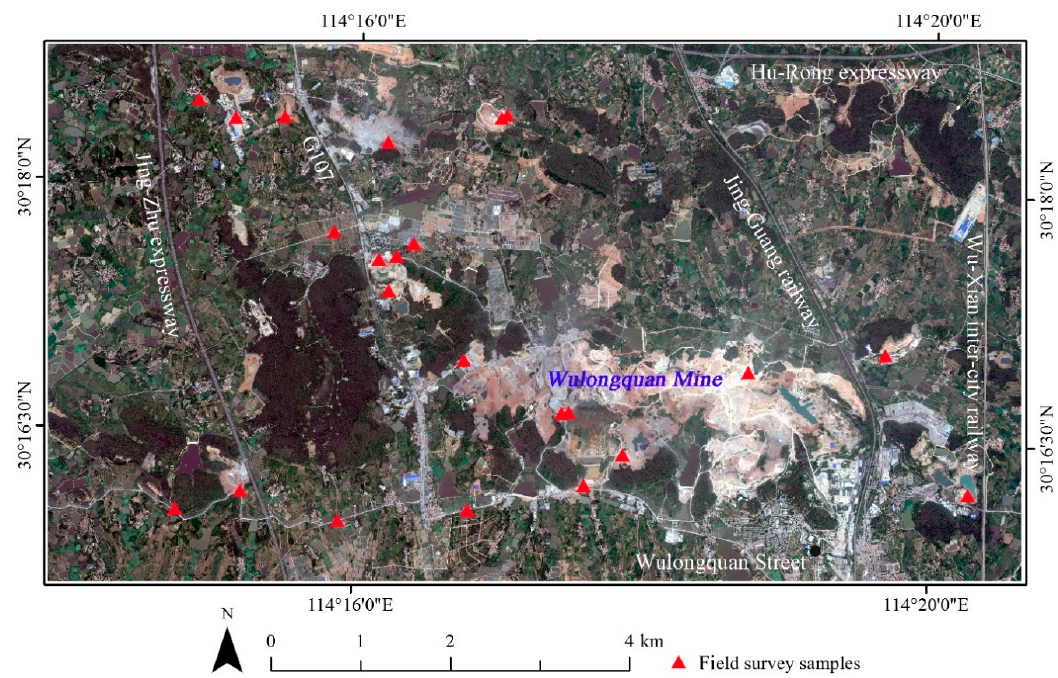
Figure 1. Study area and WV-3 fused true color image. RGB = band 5, 3, 2.